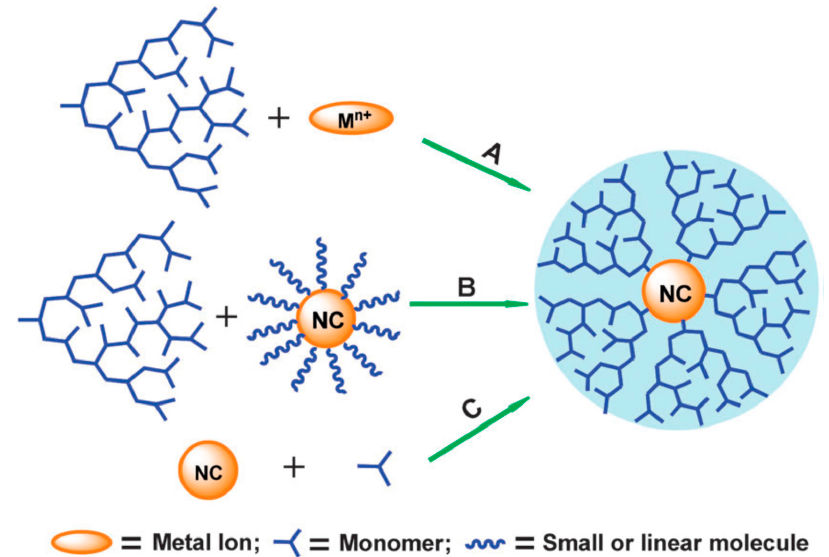
Figure 5. HMs as stabilizer for nanocrystals (NCs): (A) HMs first, (B) ligand exchange, and (C) NCs first. Reproduced from [7] with permission from the Royal Society of